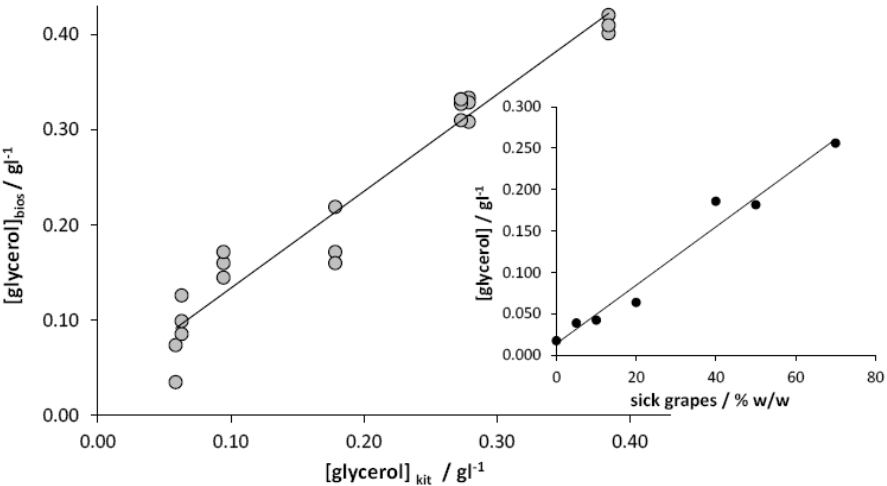
Figure 4. Correlation plot between the concentration of glycerol estimated with the developed automated instrument and with the enzymatic kit; samples of grapes from the same vine have been considered. Confidence limits (α = 0.05) for slope and intercept are within brackets; r 2 = 0.95. Inset reports the correlation between the glycerol concentrations estimated with the enzymatic kit and the amount of grapes affected by Botrytis .